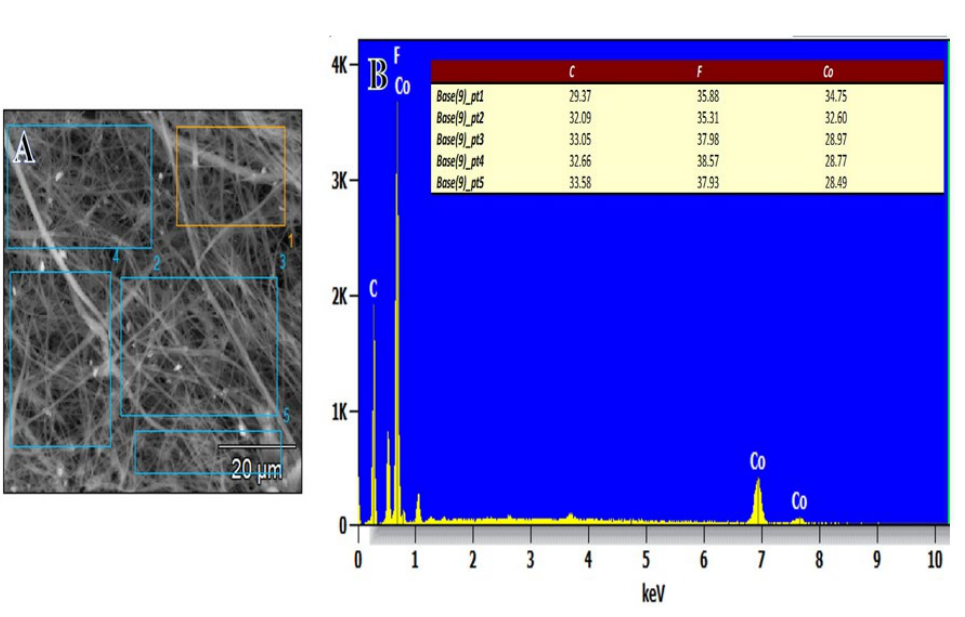
Figure 4. XRD charts of PVHF ( A ) and PVHF-40 ( B ) membranes. TGA charts (Figure 5) were used to investigate the thermal decomposition of PVHF and Co@PVHF membrane NFs. Bare PVHF film had a distinct weight loss region at 420